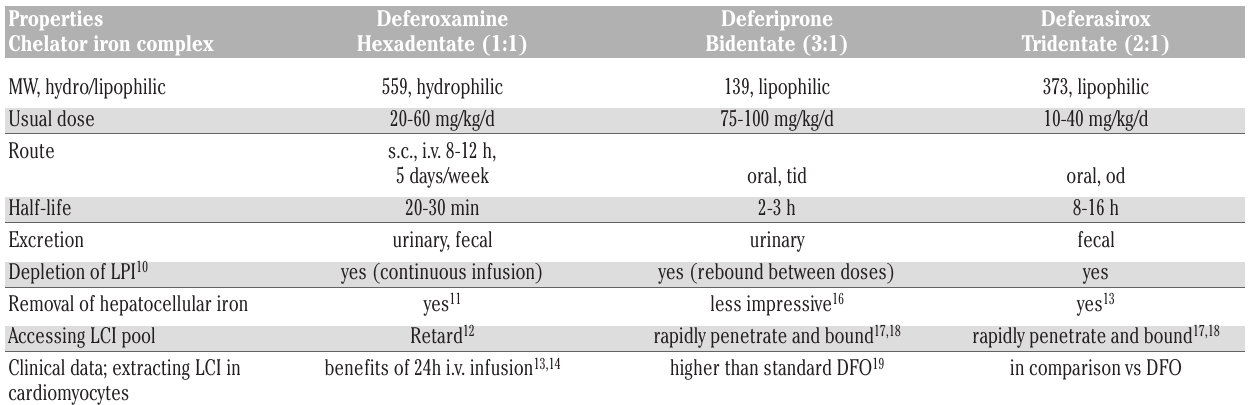
Table 1. Properties of iron